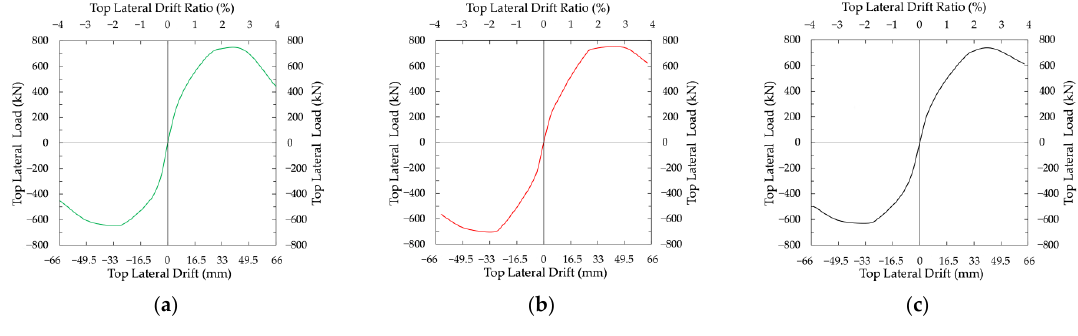
Figure 18. Skeleton curves of subassemblies. ( a ) CS-1; ( b ) CS-2; ( c ) CS-3.